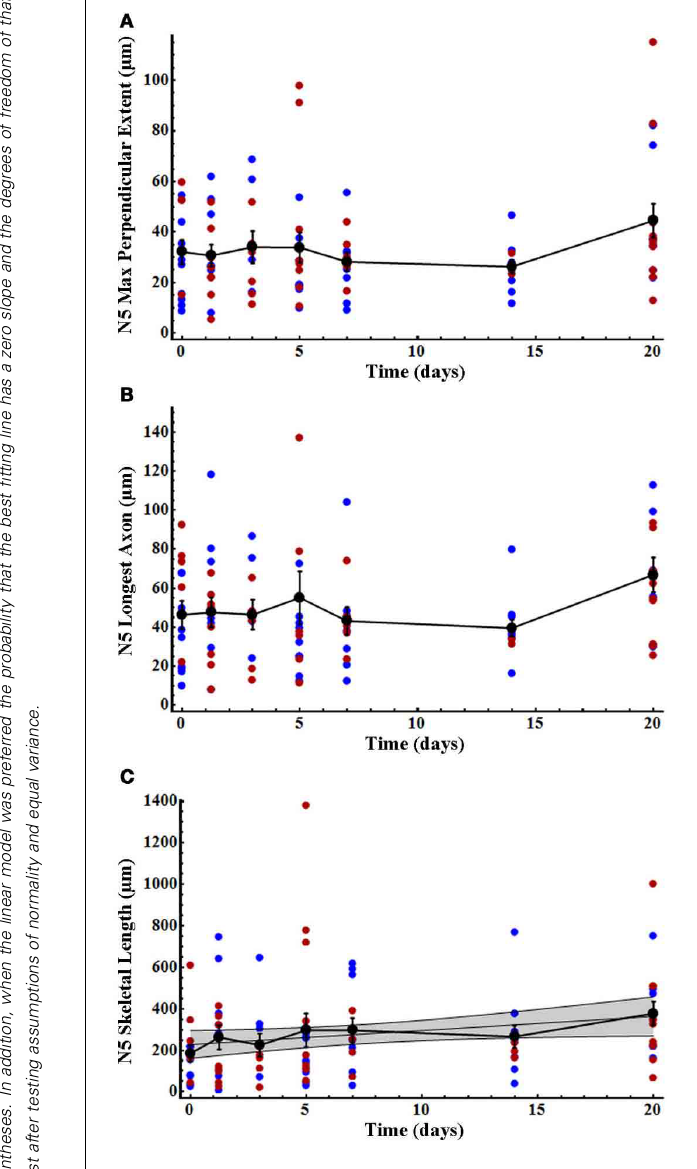
FIGURE 4 | N5 axonal skeletal length increased significantly over time after deafferentation, while the longest axon and perpendicular extent of N5 axons did not. (A) N5 axonal maximum perpendicular extent and (B) longest axon showed no significant change over the deafferentation time period while (C) skeletal length increased significantly in a linear fashion. N5 growth patterns did not differ between males (blue) and females (red). Black data points represent means, and error bars represent standard error of the mean. The shaded gray area indicates the 95% confidence interval. Female N5 control ( n = 6), 30h ( n = 9), 3 days ( n = 6), 5 days ( n = 9), 7 days ( n = 5), 14 days ( n = 3), and 20 days ( n = 10). Male N5 control ( n = 9), 30h ( n = 7), 3 days ( n = 4), 5 days ( n = 9), 7 days ( n = 7), 14 days ( n = 9), and 20 days ( n = 7). See Table 2 for regression equations and